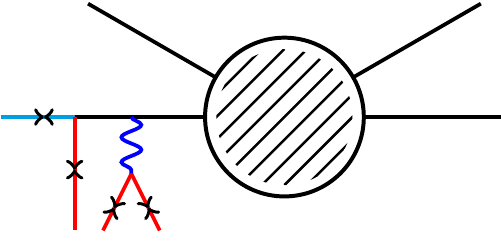
Figure 20 . Feynman diagram for three soft gravitini |